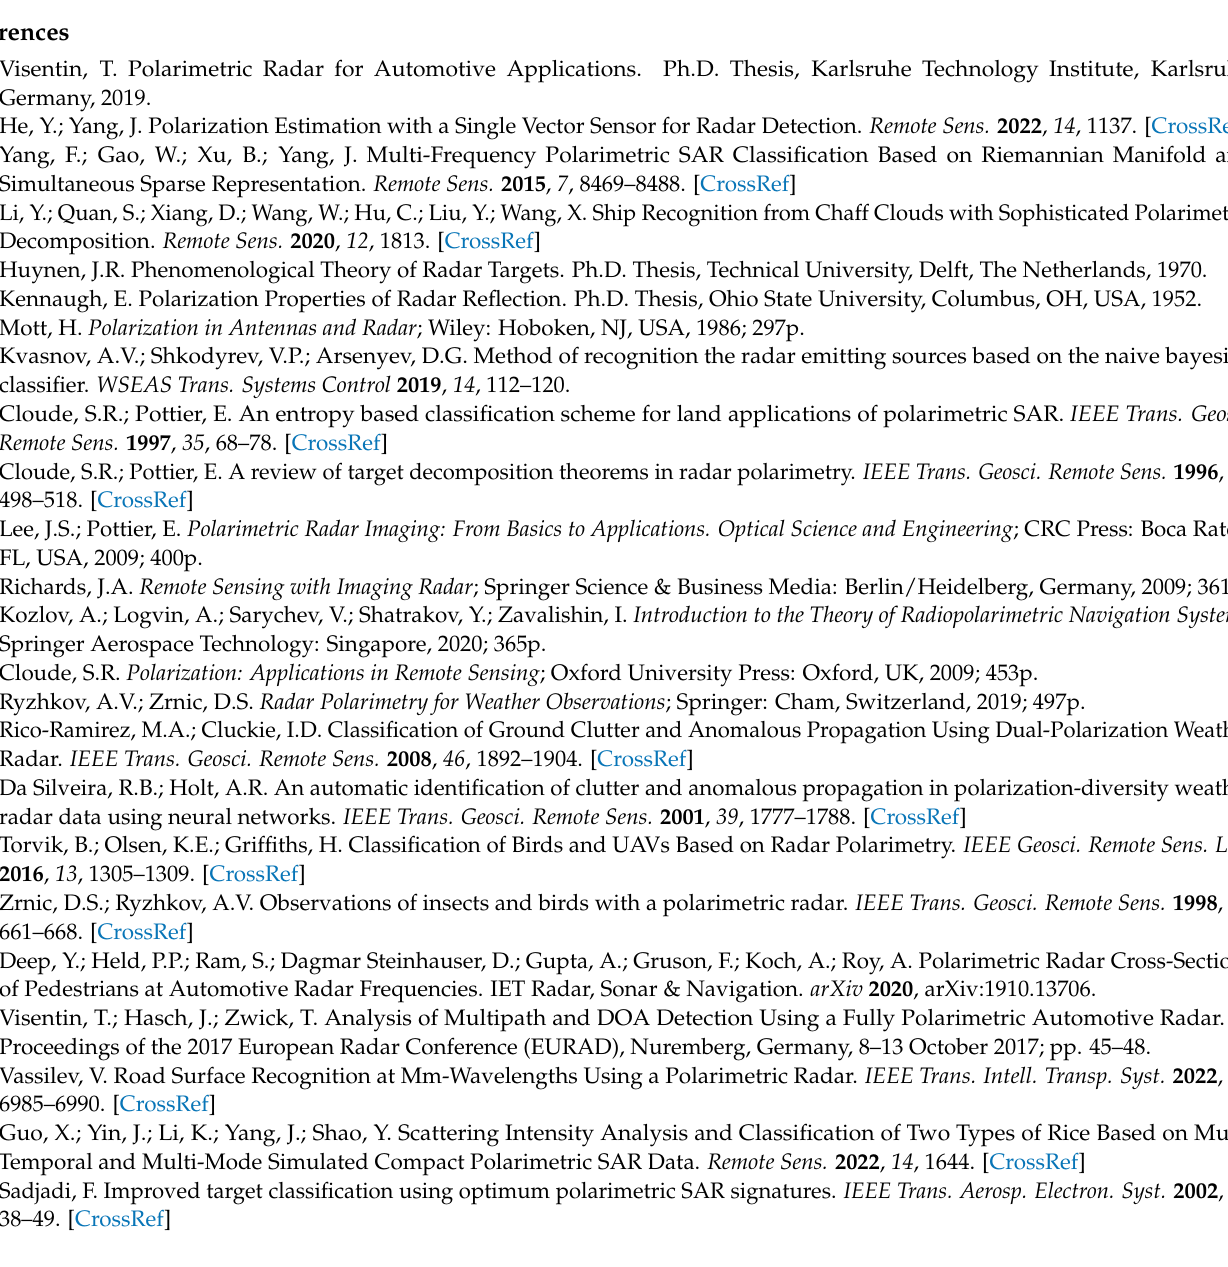
Figure A4. Confusion matrix TRP for circular